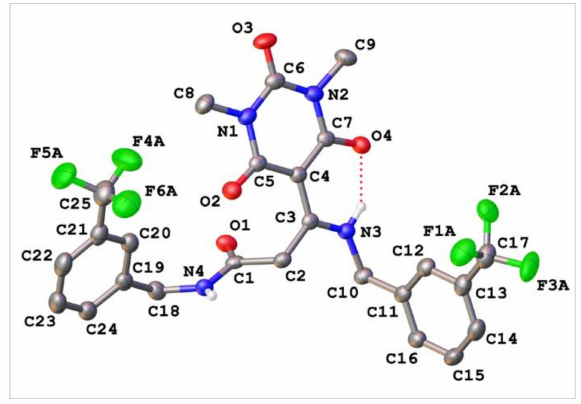
Figure A2. Crystal structure of compound 5c